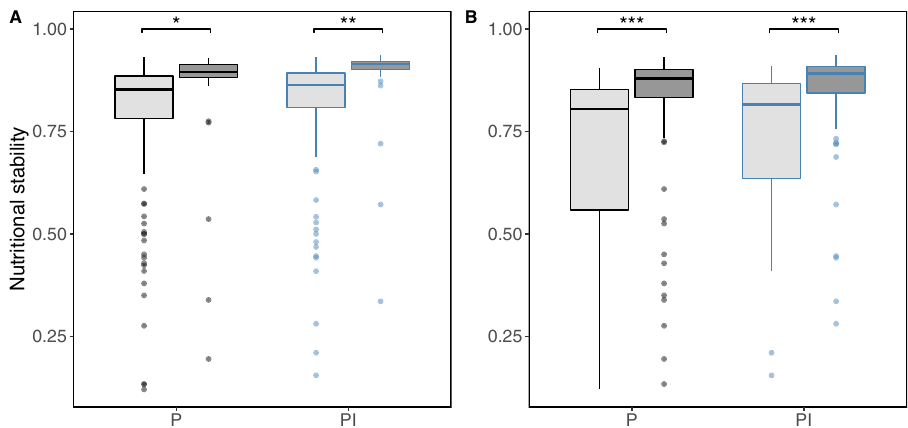
Fig. 4 National factors related to nutritional stability. Developing states ( A , light gray) and small island states ( B , light gray) had lower nutritional stability for both supply sources. Each point is a country ’ s nutritional stability averaged across years ( n = 184 countries, black: production alone; blue: production plus imports). Small island states are included in the developing states. Boxes show median and interquartile range (25th – 75th percentiles); whiskers show values within 1.5 × IQR of the boxes. See Supplementary Table 3 for statistical comparisons, * P < 0.05, ** P < 0.01, *** P < 0.001.